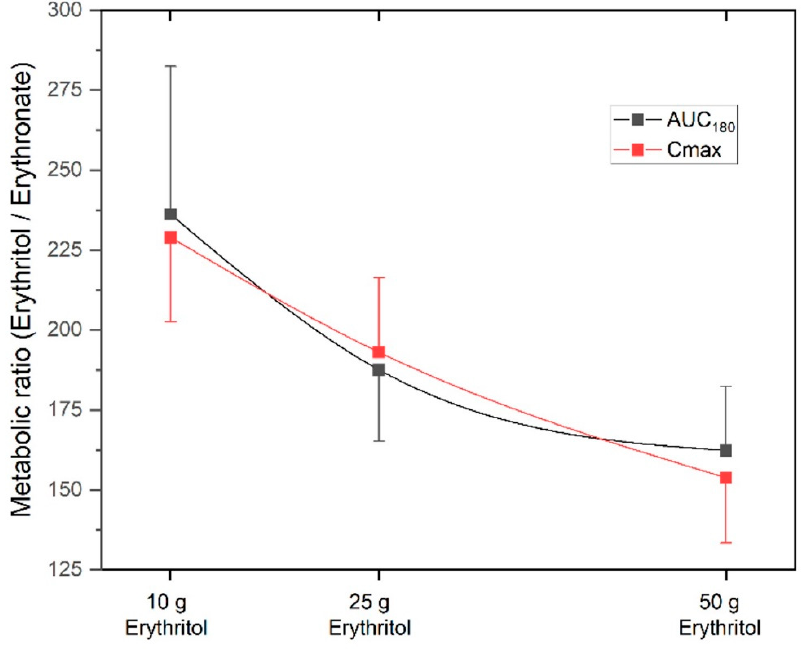
Figure 4. Metabolic ratios erythritol/erythronate for the three doses of erythritol. AUC 180 : area under the curve from 0 to 180 min, C max : maximum deviation from baseline. Data are expressed as mean ±